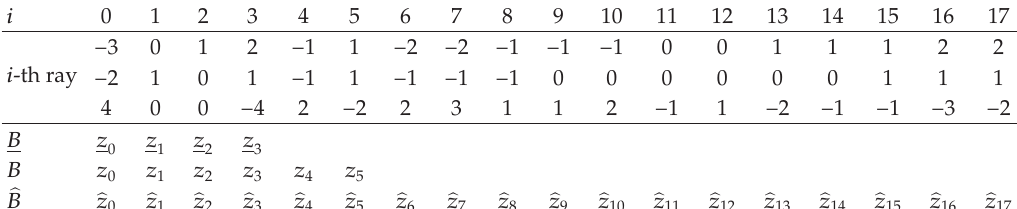
Table 1: Ray generators and the associated Cox homogeneous